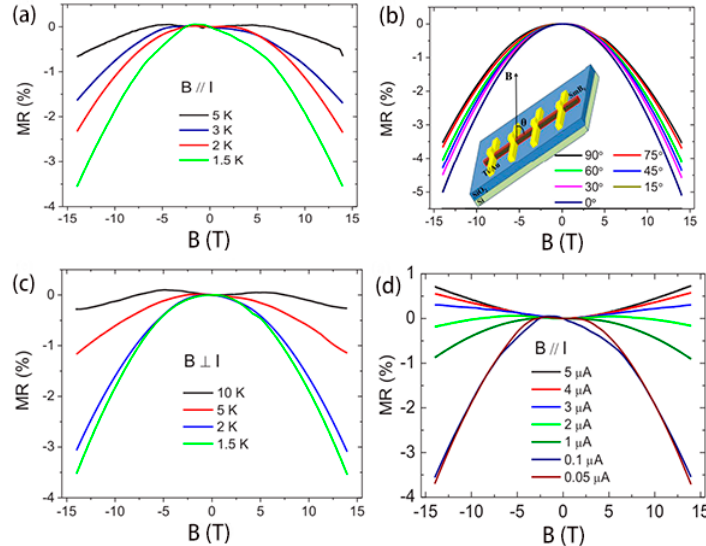
Figure 13. ( a ) The magnetoresistance (MR) for parallel magnetic field at different temperatures. ( b ) The MR measured at 1.5 K and under the magnetic field with different directions. The inset schematically shows the angle θ between the direction of the magnetic field and the longitudinal direction of the nanowire. ( c ) The MR for perpendicular magnetic fields at different temperatures. ( d ) The MR at 1.5 K for different bias currents ranging from 0.05 µ A to 5 µ A [79]. Copyright 2017, American Physical Society.